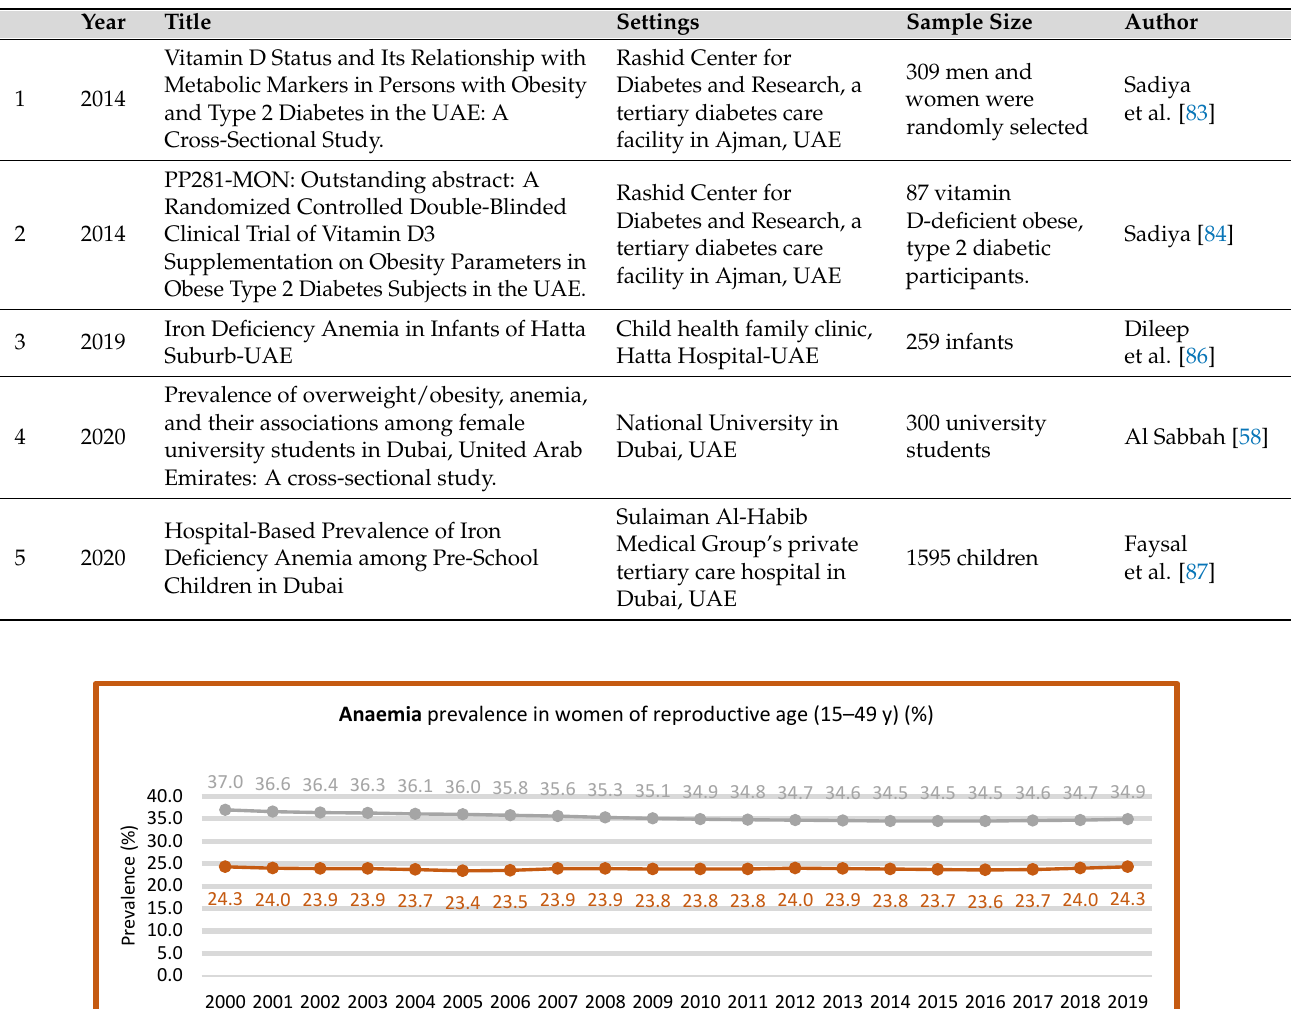
Table 4. Micronutrient deficiency.